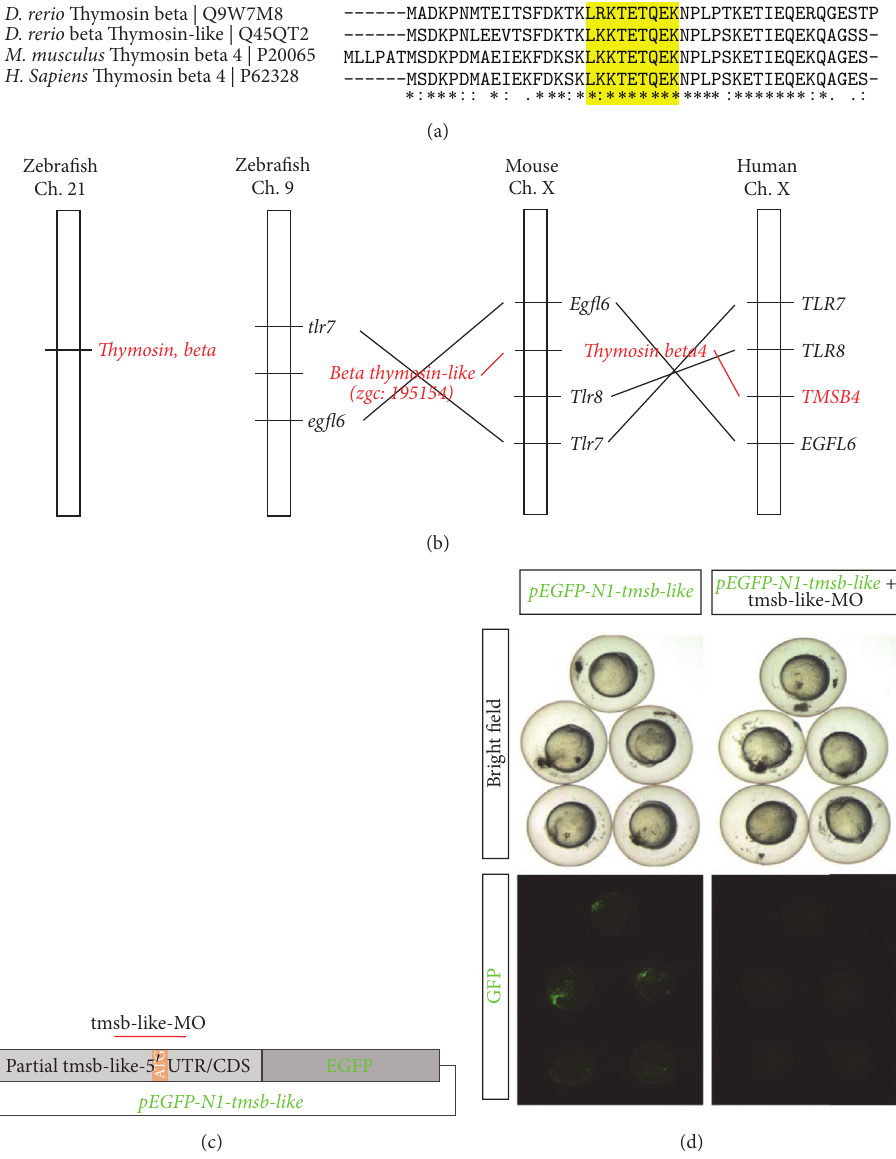
Figure 2: Identification of a Thymosin 𝛽 4 ortholog in zebrafish. (a) Amino acid sequence alignment of zebrafish beta Thymosin and beta Thymosin-like and mouse and human Thymosin 𝛽 4. The yellow box indicates the consensus actin binding motif, indicating a closer degree of homology of zebrafish beta Thymosin-like to the mammalian Thymosins than beta Thymosin. (b) The comparison of the genomic localization of beta Thymosin and beta Thymosin-like in zebrafish, in relation to the murine and human localization, shows a closer proximity of beta Thymosin-like than beta Thymosin to the mammalian Thymosin 𝛽 4. (c) Vector used to integrate pEGFP-N1-tmsb-like in zebrafish with indicated binding site of tmsb-like morpholinos (tmsb-like-MO) used to knockdown tmsb-like in zebrafish. (d) Treatment of pEGFP-N1- tmsb-like expressing zebrafish embryos with tmsb-like-MO demonstrates high knockdown